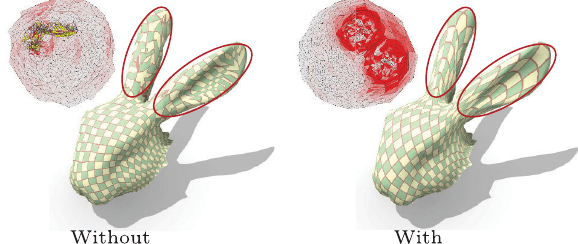
Fig. 3 Parameterizations with/without inversion-free constraints. The yellow triangles in the left image indicate the inverted triangles. The color on triangles encodes the distortion, with white being